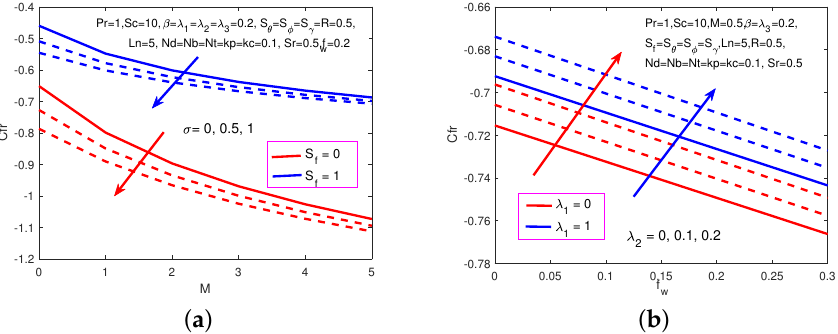
Figure 14. Influence of M , σ , S f , λ 1 , λ 2 , and f w on the skin friction coefficient. ( a ) No hydrodynamic slip and with hydrodynamic slip. ( b ) No thermal buoyancy and with thermal buoyancy.